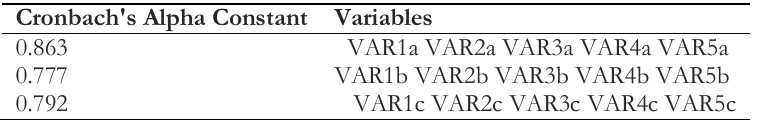
Table 1. Cronbach's Alpha constant for three dimensions.